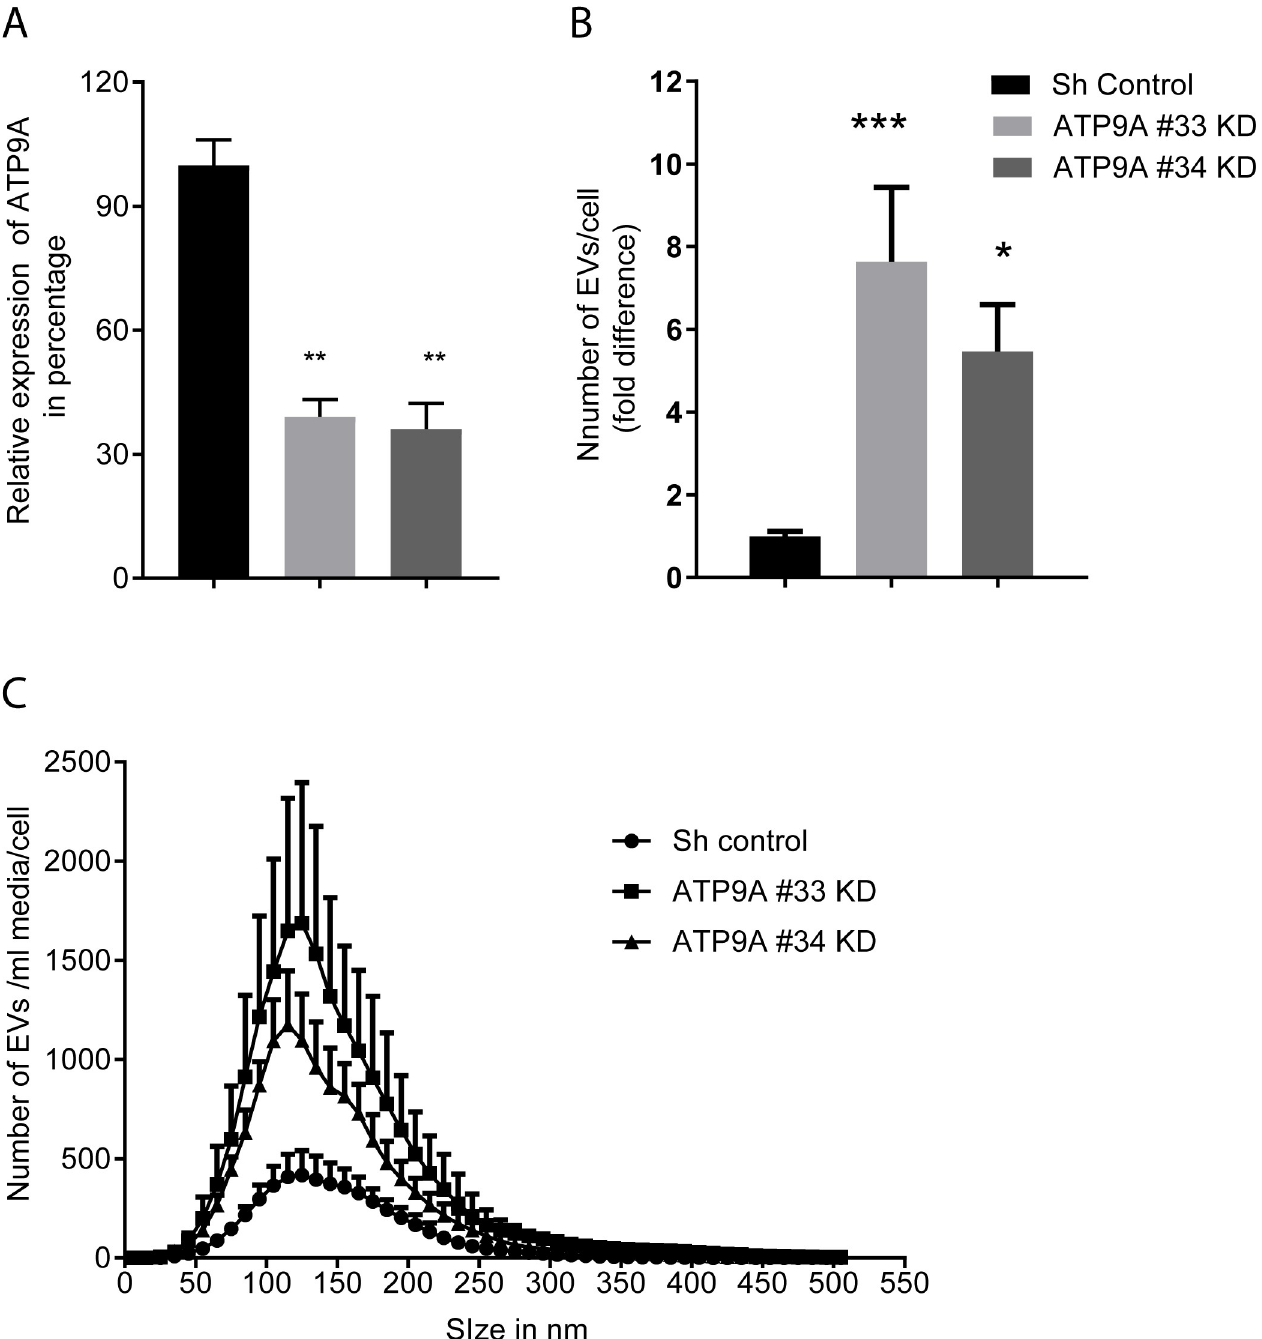
Fig 1. ATP9A knock-down in HepG2 cells enhances EV release. HepG2 cells were transduced with shATP9A #33, #34 or sh-control. Cells and medium were harvested 116 hours after transduction. (A) Ratio of ATP9A mRNA / geometric mean of HRPT and 36B4 . Data were presented as mean of 8 independent experiments ± standard error of mean (SEM). (B) Number of EVs/ml/cell in medium of ATP9A knock-down and sh-control cells. Values were expressed as mean of 8 independent experiments ± standard error of mean (SEM). (C) Size distribution of EVs in culture medium of sh control cells and ATP9A knock- down cells. For statistical significance One way ANOVA with Dunnett’s multiple comparison test was done. � P < 0.05, �� p < 0.005, ��� P < 0.0005.